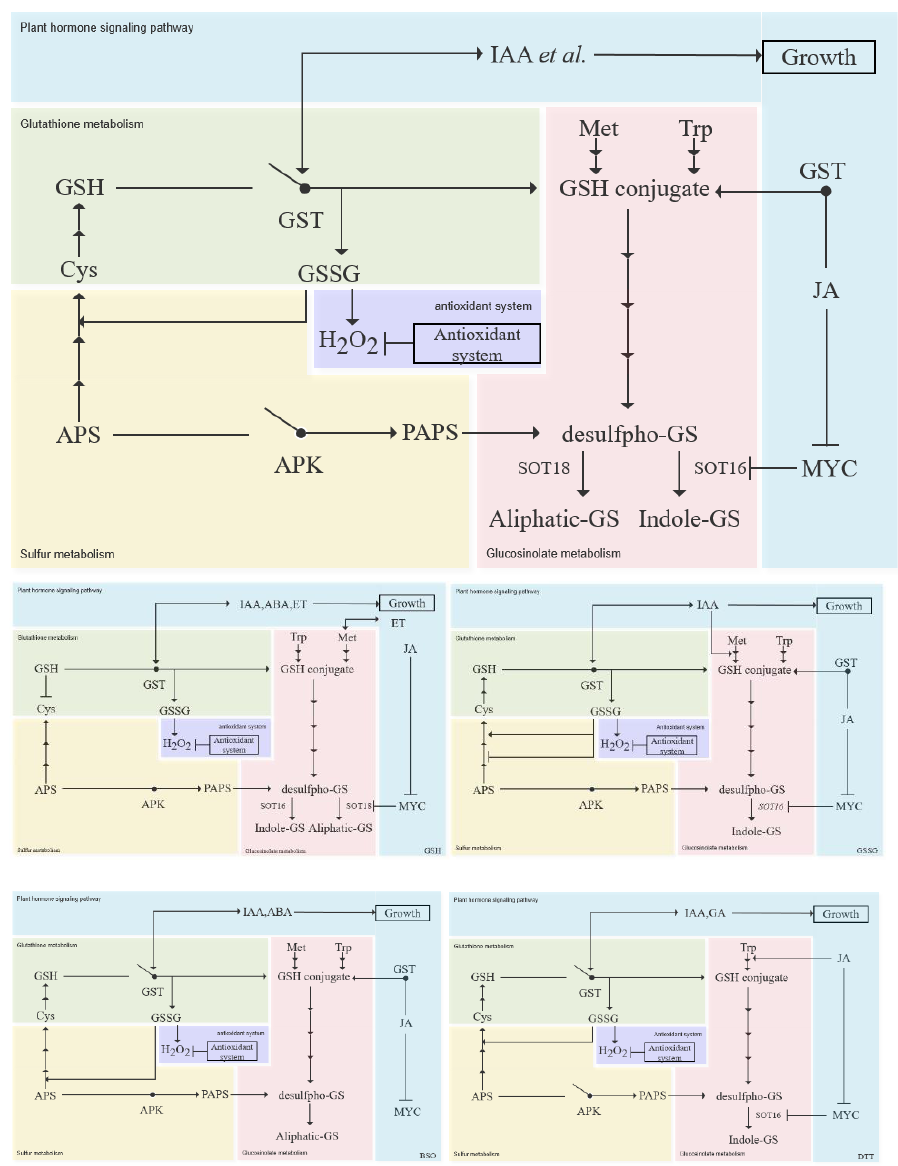
Figure 12. Model of how GSH keeps balance between antioxidant response and GS metabolism in pakchoi.